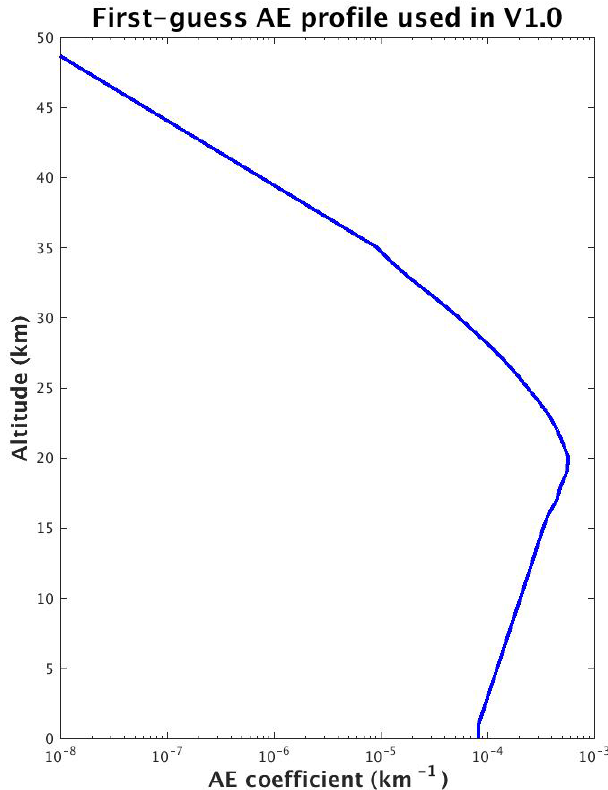
Figure 17. The first-guess aerosol extinction (or AE) profile used in the V1 OMPS LP aerosol extinction retrieval